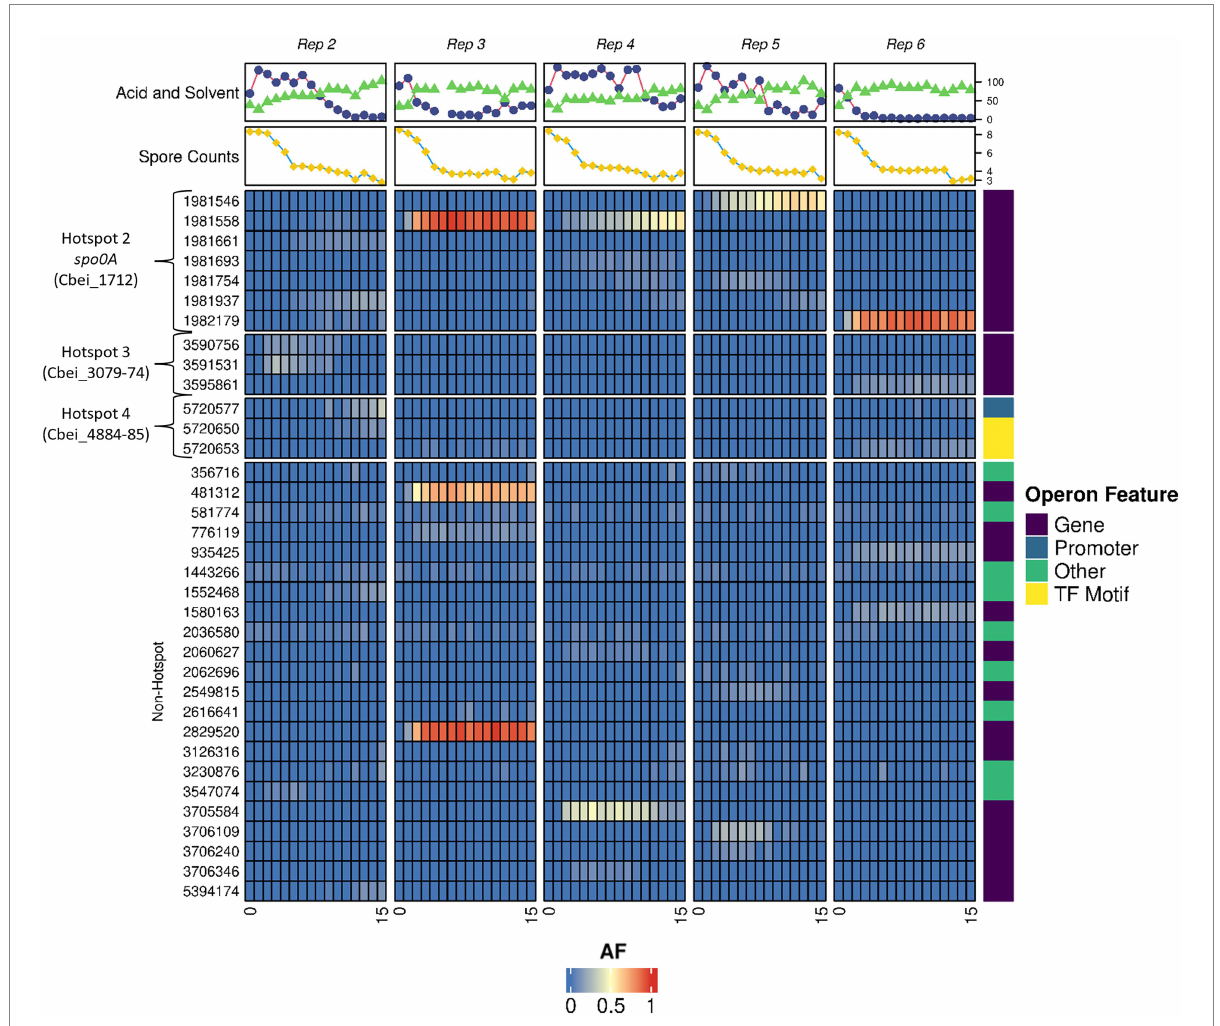
FIGURE 3 Allele frequency dynamics in degenerating Clostridium beijerinckii cultures. Heatmap showing the frequency of mutations emerging within the populations of 5 individual subculture series. Subculture numbers for each series are indicated at the bottom of map. AF is the allele frequency. Hotspot regions 2, 3, and 4 are shown along with non-hotspot regions where other mutations were found. Solvent (Blue circles) and acid (Green triangles) concentrations (mM) alongside spore counts (10 x heat resistant CFU/ml; yellow squares) are displayed for each individual subculturing point. Operon feature shows whether the mutations affects the gene, promoter region, transcription factor motif or other region. All variants called for the heatmap can found in Supplementary Table 4B. Median read depth reported by Freebayes and Lofreq was 368 and 385,